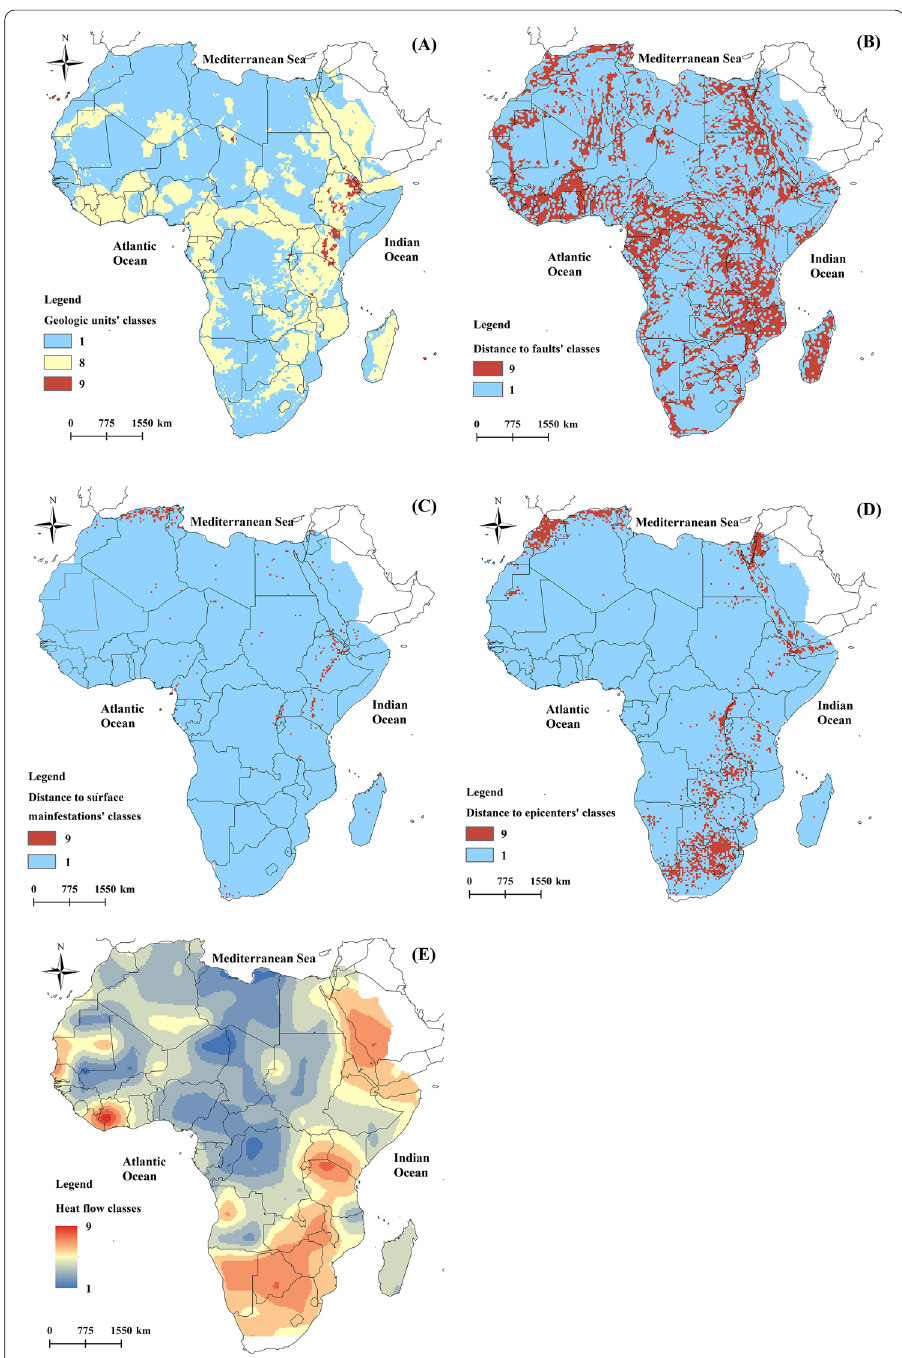
Fig. 6 Standardization of the five criteria layers based on decision‑maker’s experience‑based suitability evaluation (from 1 to 9), where higher rates imply a better potential for geothermal energy: A geologic units, classified into three major types: sedimentary rocks (lower rank), basement, and volcanic rocks (higher rank); B distance to fault lines, where sites less than 6000 m from fault lines are ranked top; C distance to surface manifestations, with locations less than 5 km ranking highest; D distance to epicenters, where sites less than 6000 m from epicenters are ranked top and E heat flow, in which a greater value correlates to a higher class of